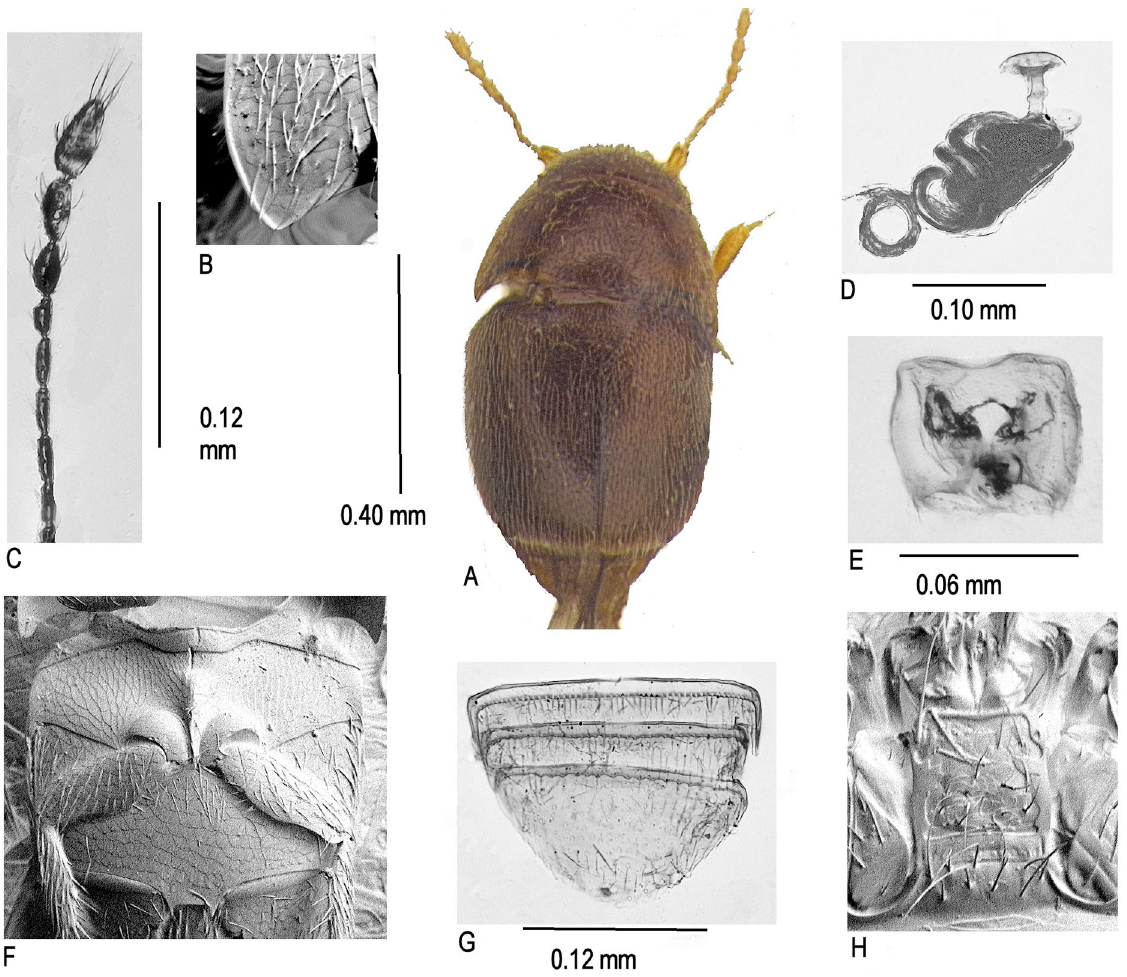
Fig. 15. Acrotrichis belli sp. nov. A . Habitus. B . Hind angle of pronotum ×1460. C . Antennomeres III–XI. D . Spermatheca. E . Aedeagus. F . Meso- and metaventra ×420. G . Pygidium. H . Mentum and submentum